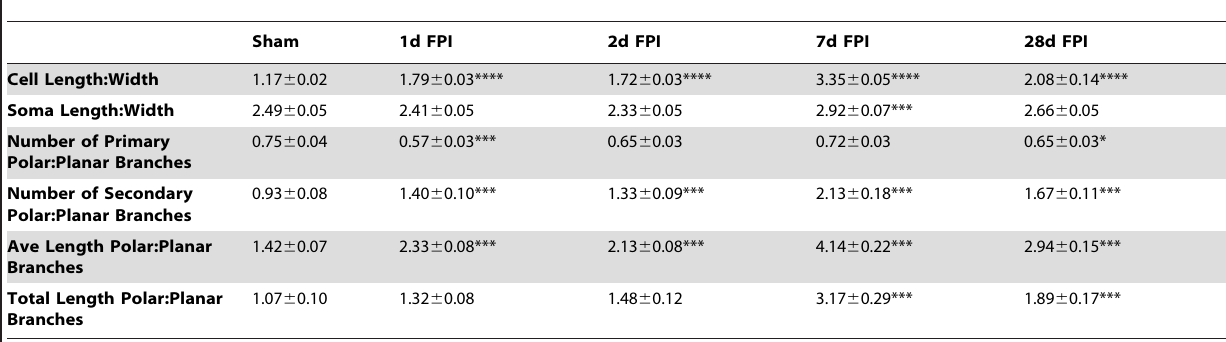
Table 1 : Ratios of morphological data for rod microglia.